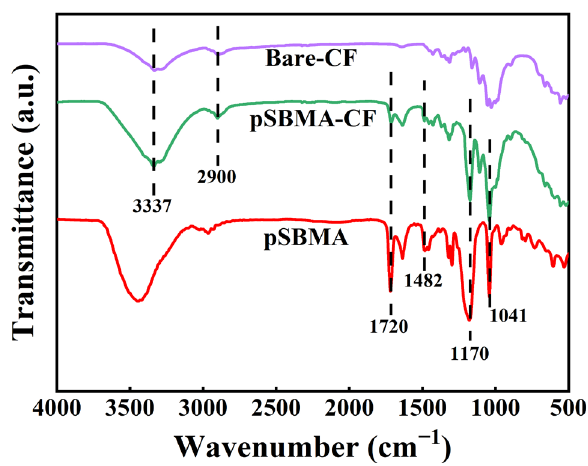
Figure 3. The FT-IR spectra of pSBMA, bare-CF and pSBMA-CF.